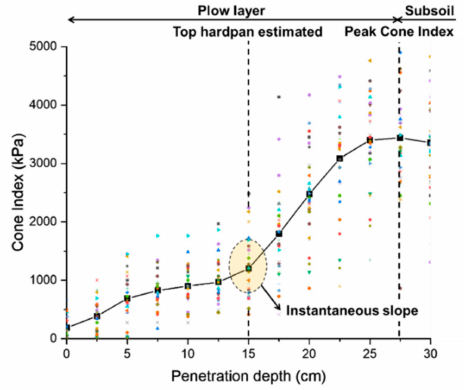
Figure 7. Results of average cone index according to penetration depth.